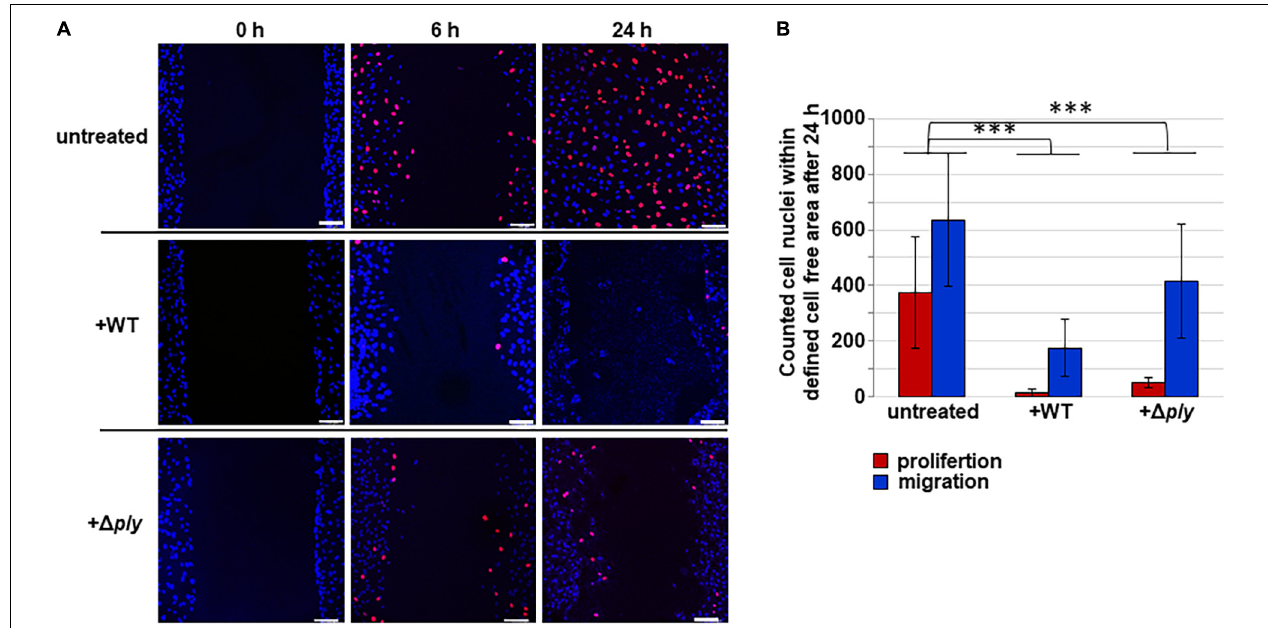
FIGURE 4 | Differential microscopic evaluation of cell proliferation and cell migration. (A) CSMA was performed for indicated time periods without bacteria (untreated), with serotype 35 A pneumococci (+WT) at MOI of 10 and with pneumolysin-deficient derivative (+ (cid:49) ply ) in the presence of 5-ethynyl-2 (cid:48) -deoxythymidine (EdU-Click), which incorporates into proliferating cell nuclei. In combination with 6-FAM-azide, nuclei of proliferating cells appear in light red, whereas migrating cells are counter-stained in blue by DAPI incubation. In CSMA samples without bacteria, gap closure was completed after 24 h of cell cultivation. In the presence of wild-type pneumococci and in the presence of pneumolysin-deficient pneumococci, the cell-free gaps are not completely closed after 24 h of cell cultivation. Representative microscopic fluorescence images are shown for each sample. Scale bar indicates 100 µ m. (B) Proportion of proliferating cells versus migrating cells was quantified by counting the red and blue fluorescing cell nuclei in the defined gap area at indicated time points (0, 6, and 24 h). Red bars indicate cell proliferation, and blue bars indicate cell migration. Experiments were performed in three independent assays, each in triplicate, and a minimum of four different fields of view were randomly chosen for quantification of cell nuclei. Data are expressed as mean value including standard deviation. ∗∗∗ indicates p < 0.001 according to two-tailed Welch’s T